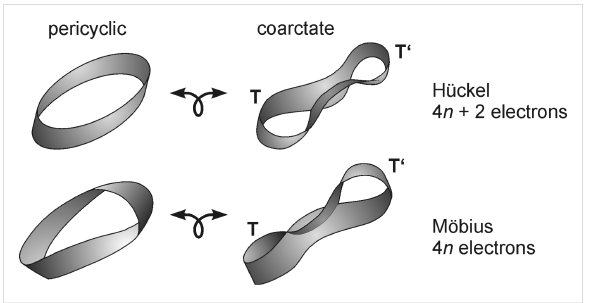
Figure 2: Stereochemistry of coarctate reactions derived from a Hückel (top) and a Möbius band (bottom). The terminator loops T and T’ are coplanar in the coarctate Hückel system and orthogonal in the coarctate Möbius transition